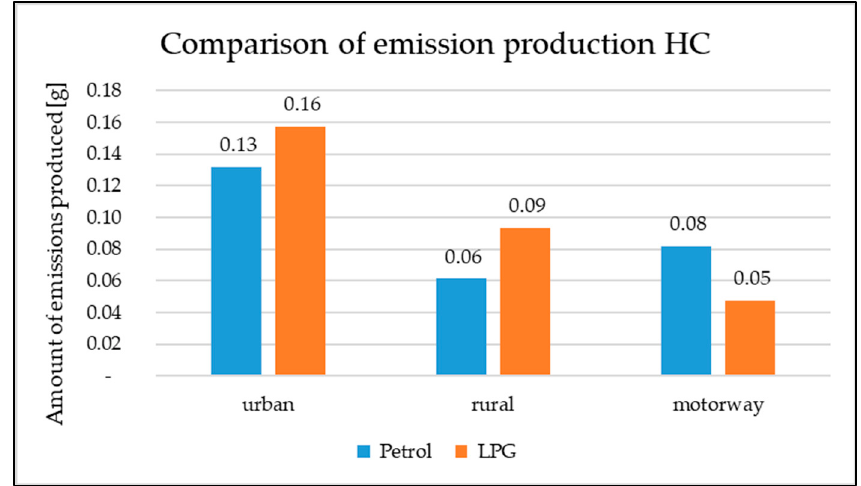
Energies 2022 , 15 , 1184 16 of 24